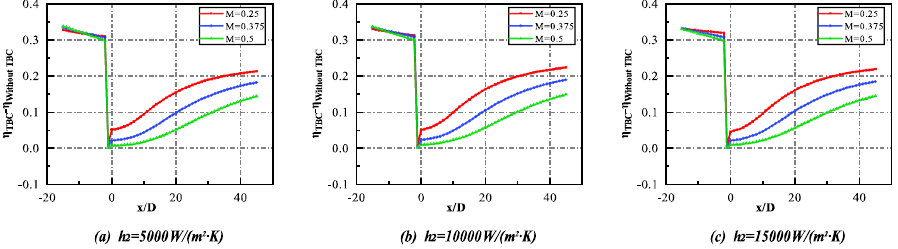
Figure 9. Distribution of (cid:4666)𝜂 (cid:3021)(cid:3003)(cid:3004) (cid:3398) 𝜂 (cid:3024)(cid:3036)(cid:3047)(cid:3035)(cid:3042)(cid:3048)(cid:3047) (cid:3021)(cid:3003)(cid:3004) (cid:4667) at different BR under γ (cid:3404) 9 and different h 2 .